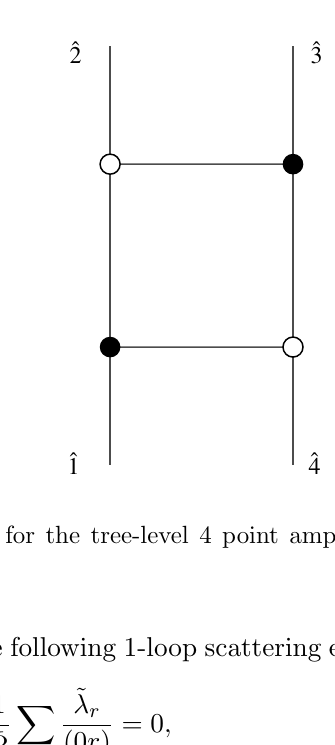
Figure 26 . On-shell diagram for the 1-loop 4 point amplitude in N = 4 SYM.